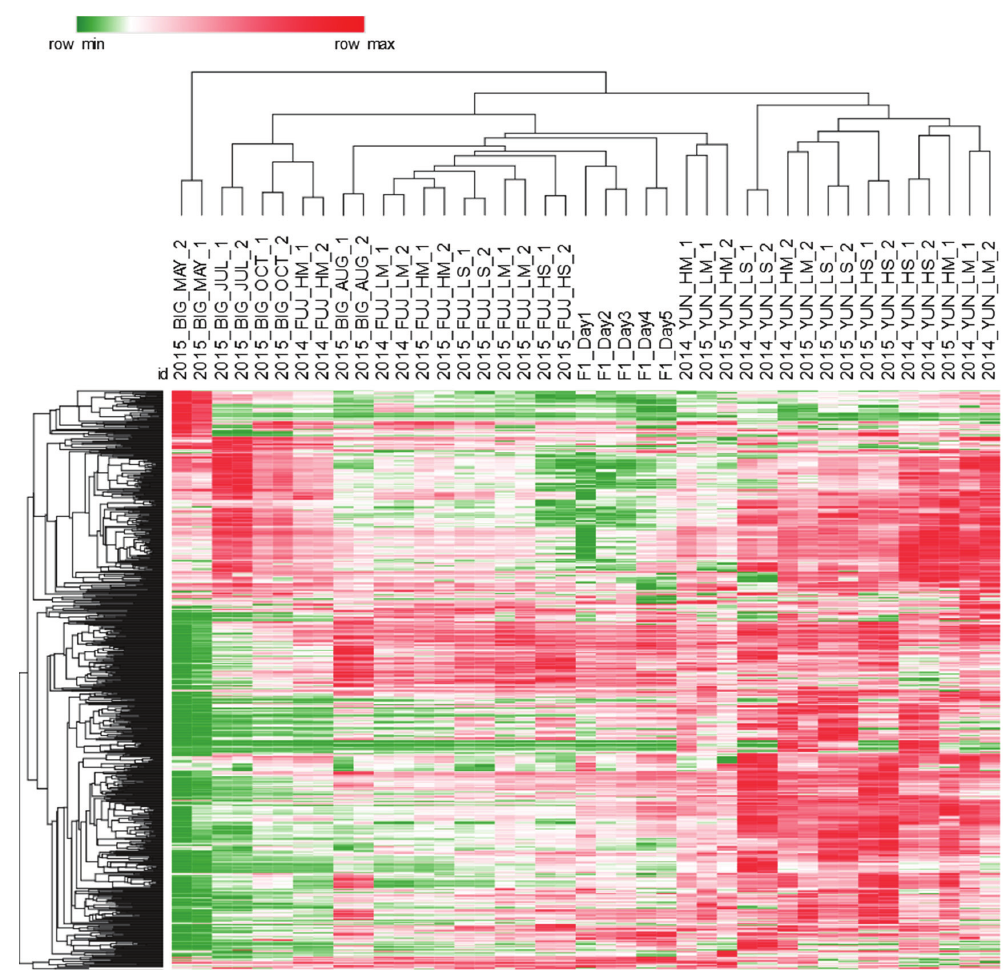
Figure 2. Heat-map visualization of % response data for 760 UT peak-regions cross-aligned on all samples (cid:541) patterns (41 samples including quality controls (QCs)). Hierarchical clustering was based on Euclidean distance metric and was performed after Z-score normalization of the data. Sample acronyms are reported in Section 4.2. Samples clustering, although incomplete, is guided by processing: Yunnan-pu (cid:541) erh teas contains an overall higher abundance of primary metabolites, as highlighted by the predominance of red spots, and also Fujian-oolong teas, despite of some misclassified samples, are clustered independently from Bigelow-black tea.